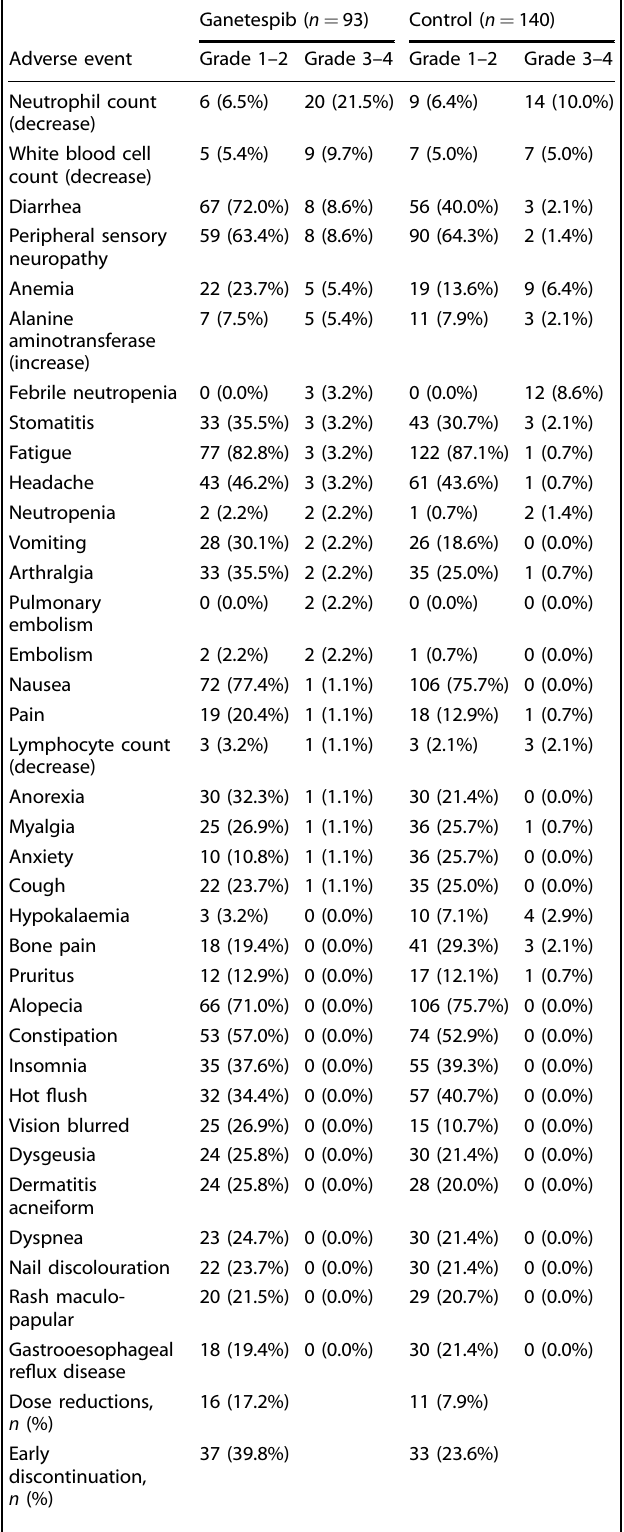
Table 2. Adverse events occurring in ganetespib and control arms; Grade 3/4 observed in ≥ 2% of participants or Grade 1/2 ≥ 20% of participants; dose reductions and early discontinuations (number, % of participants in arm/treatment